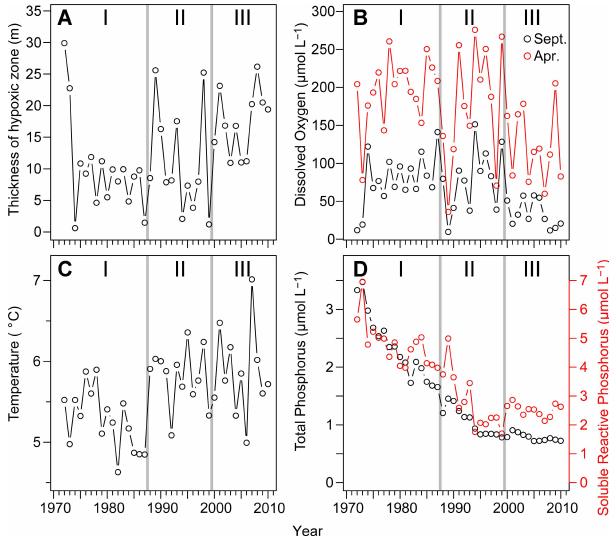
Fig. 15. Lake Zurich data set (1972–2010). ( A ) Thickness of the hy- poxic zone (oxygen concentrations < 62.5µmolL − 1 / < 2mgL − 1 ) in September. ( B ) Mean volume-weighted deep-water (120–136m) oxygen concentration in September (black) and in the previous April (red). ( C ) Mean volume-weighted temperature of the up- permost 20m of the lake from December to April. ( D ) Mean an- nual volume-weighted concentration of total phosphorus (black) in the entire lake (0–136m) and of soluble reactive phosphorus (red) in the deep water (120–136m). For further information see North et al. (2013,